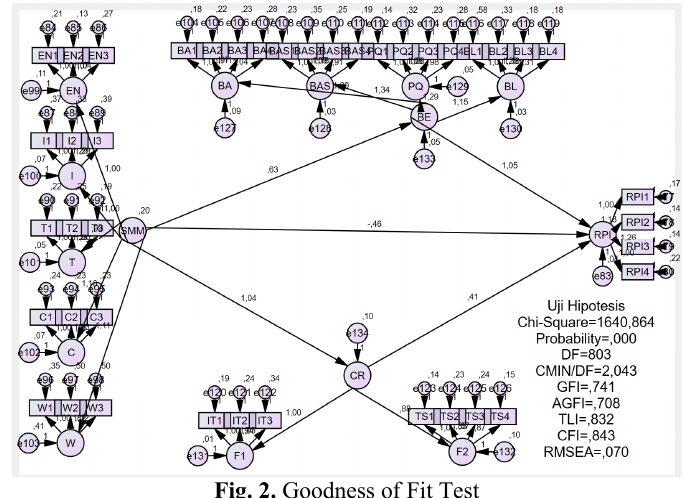
Fig. 2. Goodness of Fit